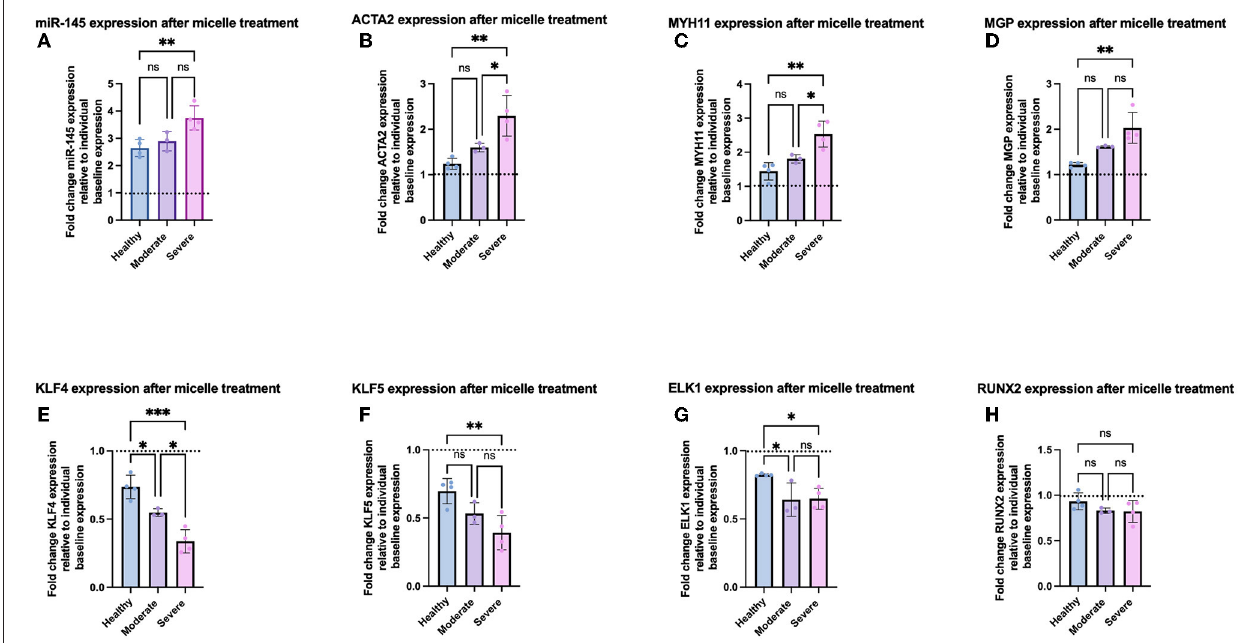
FIGURE 5 | Gene expression of VSMCs after miR-145 micelle treatment based on disease severity. qRT-PCR analysis shows increased (A) miR-145 levels, (B) ACTA2, (C) MYH11, (D ) MGP, and decreased (E) KLF4, (F) KLF5, (G) ELK1, and (H) RUNX2. Dotted line indicates individual baseline gene expression. * p < 0.05, ** p < 0.01, and *** p <